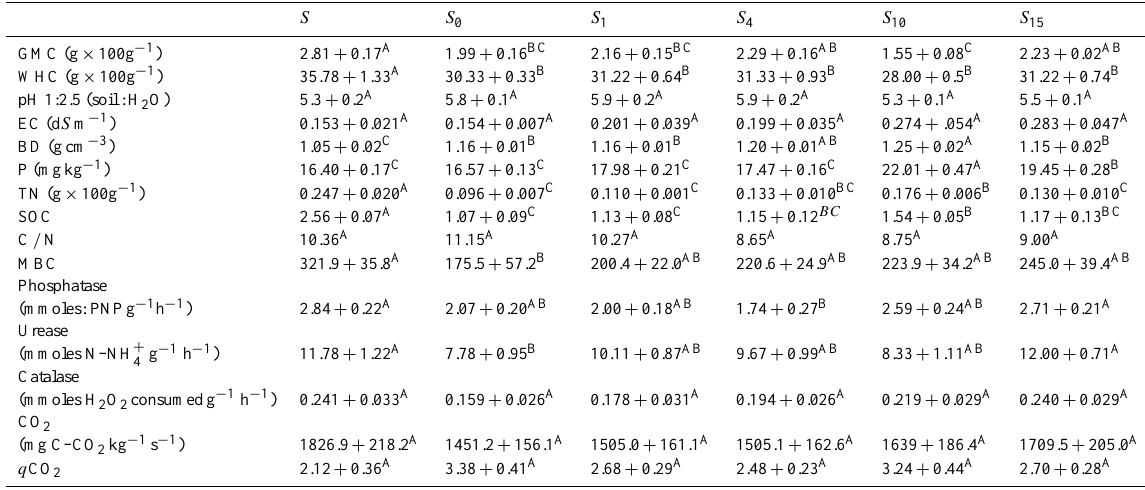
Table 1. Properties of soil samples with different years of extraction of pumice.